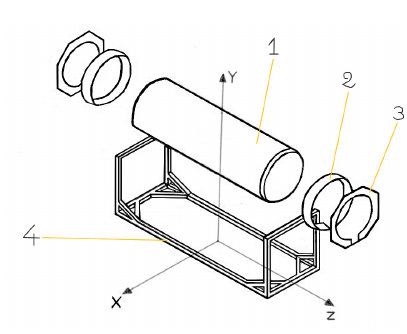
Figure 1. Model of the tank container.